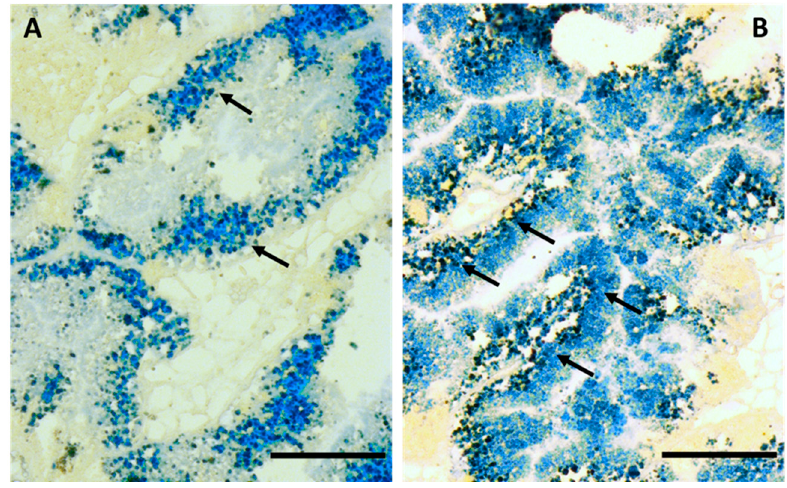
Figure 6. Lipofuscin staining in digestive cells of the tubular epithelium in the midgut gland of ( A ) a control periwinkle and, ( B ) an individual of the CdH group after 21 days of exposure. Scale bars: 200 µm; arrows indicate lipofuscin granules.